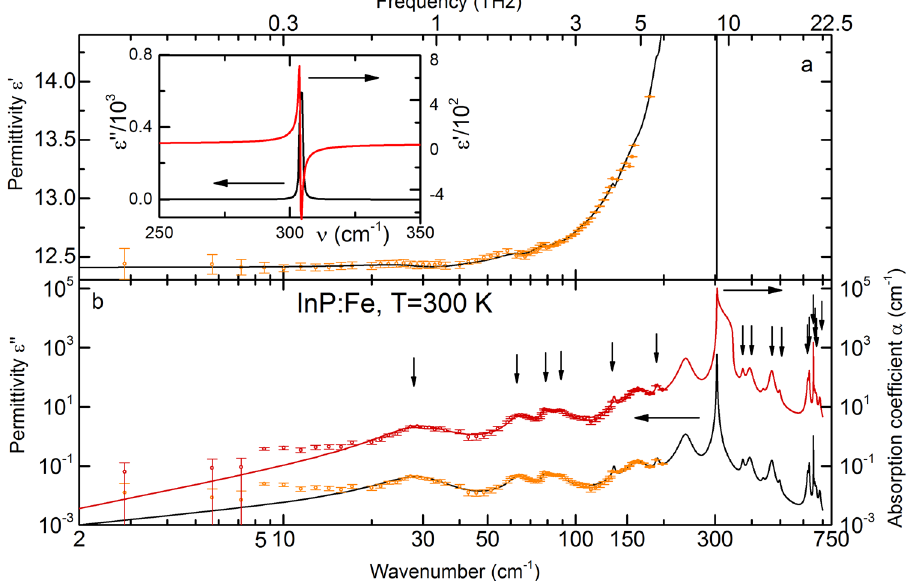
Figure 2. Room temperature terahertz-infrared spectra of the real ( a ) and imaginary (left vertical axis in panel ( b )) parts of the dielectric permittivity and of the absorption coefficient α (right vertical axis in panel ( b )) of Fe-doped InP. Dots are the experimental data, solid lines are the modeling curves described in the main text. The weak absorption lines assigned to multi-phonon interaction are designated with vertical arrows in panel b. The key parameters of the absorption lines are presented in Table 1 (cf. Eq. (1)). The inset in panel ( a ) shows the dielectric permittivity near the transverse optical phonon